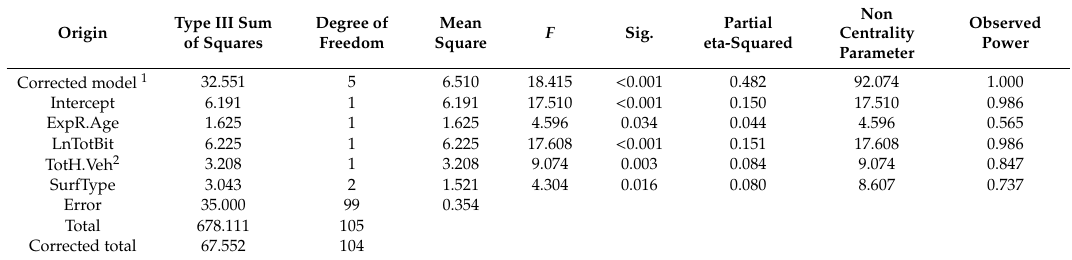
Table 12. Test of Between-Subjects e ff ects for the model of Equation (15).